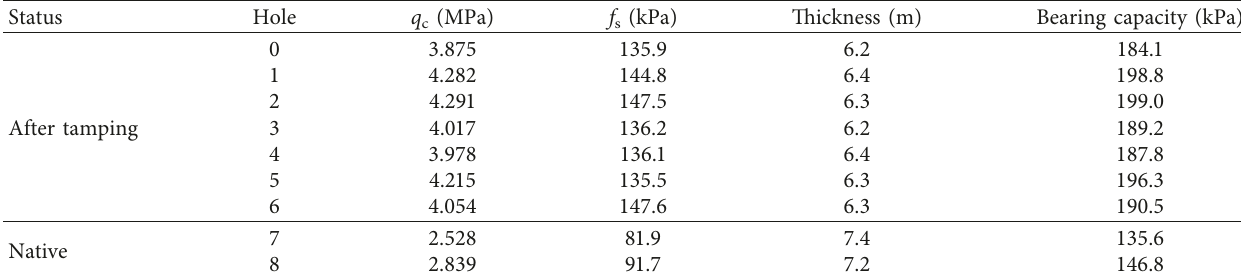
Table 4: Results of CPT on fly ash after dynamic